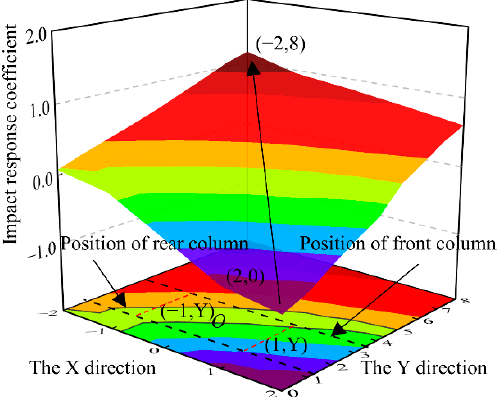
Figure 8. Impact response coefficient of the hinge point of the caving shield.